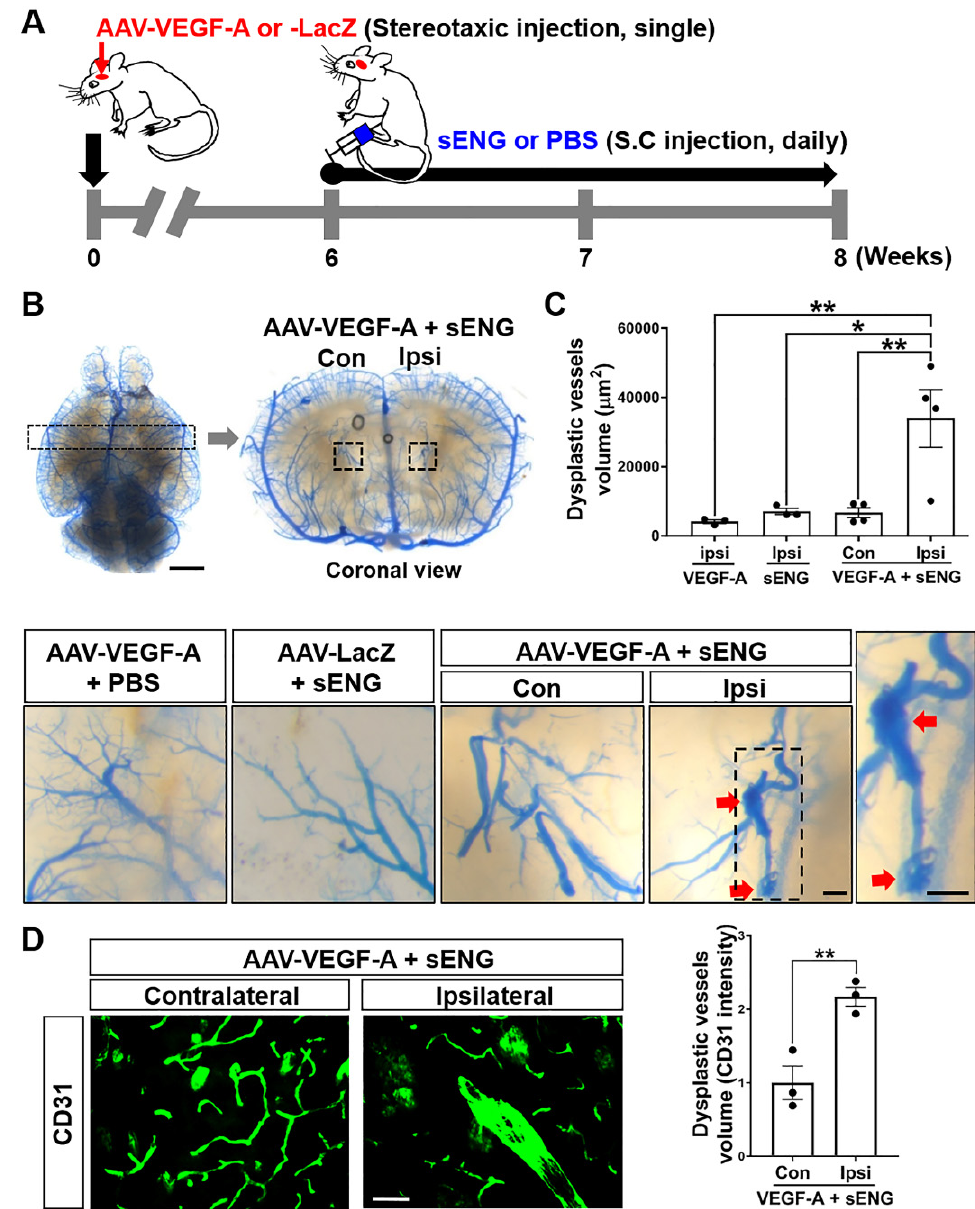
Figure 1. Soluble ENG/VEGF-A induces the formation of dysplastic vessels in the mouse brain. ( A ) Experimental scheme for sENG and AAV1-VEGF-A injection. The mice were stereotaxically injected with AAV1-VEGF-A (or AAV1-LacZ) into the intra-striatum and administered recombinant sENG (or PBS) subcutaneously (s.c.) every day for two weeks beginning at six weeks after the AAV1-VEGF-A injection. At eight weeks after the AAV1-VEGF-A injection, the mice were sacrificed. ( B ) Representative images of latex cast-clarified brains in mice injected with AAV1-VEGF-A + PBS, AAV1-LacZ + sENG, and AAV1-VEGF-A + sENG. Coronal sections showed the enlarged abnormal vasculature (inset, arrows) in the AAV1-VEGF-A injected site (ipsilateral) compared to the non-injected site (contralateral) in mice injected with AAV1-VEGF-A and sENG. Scale bars: 2 mm (whole brain image) and 100 μ m (inset). ( C ) The quantification of vessel volume in mouse brains. AAV-VEGF-A (or VEGF-A), mice injected with vehicle (PBS) and AAV1-VEGF-A, sENG, mice injected with sENG and AAV1-LacZ, AAV-VEGF-A (or VEGF-A) + sENG, mice injected with AAV1-VEGF-A and sENG. n = 3–4, * p < 0.05, ** p < 0.01, One-way ANOVA. ( D ) Image of CD31 immunostained brain from mice injected with sENG and AAV1-VEGF-A and the quantification of CD31 intensity. Scale bar: 50 μ m, n = 3, data are presented as mean ± SEM, ** p < 0.01, Student’s t- test. Con, contralateral, Ipsi, ipsilateral.